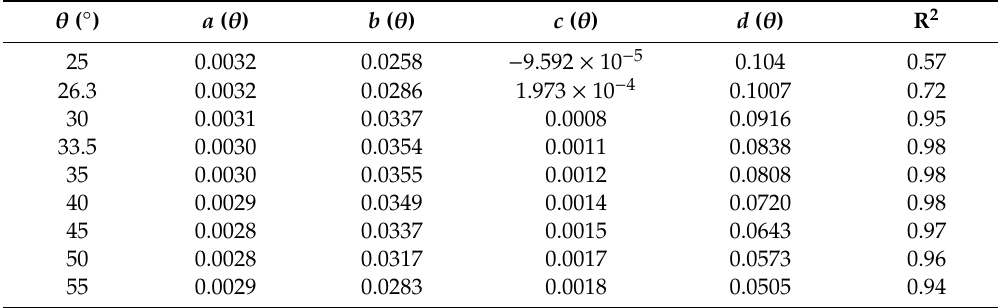
Table 3. Empirical coe ffi cients at di ff erent incidence angles in VV polarization ( Hrms ∈ (0.5, 4) cm).